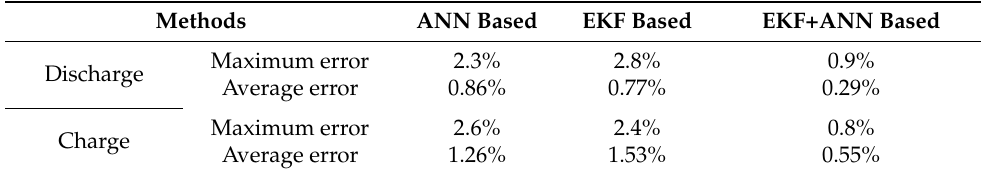
Table 7. Comparison of the designed SOC estimation methods with others.